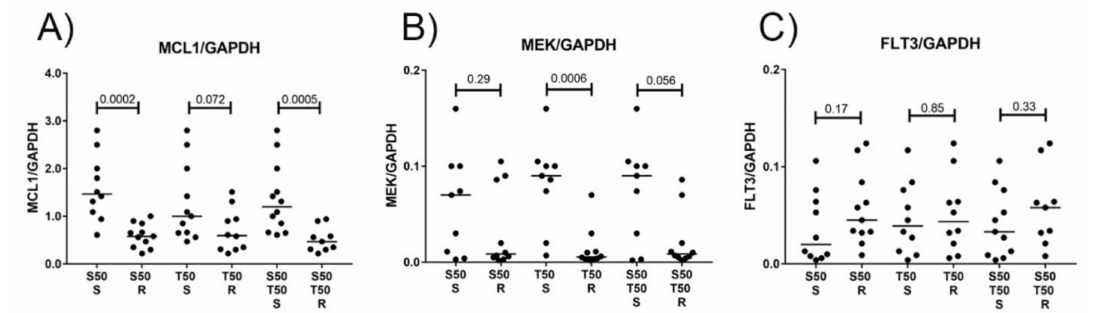
Figure 5. MCL1 and MEK1 protein levels are biomarkers for S63845 and trametinib treatment response in mononuclear cells isolated from patients with hematological malignancies. Relative protein levels of MCL1 / GAPDH( A ), MEK / GAPDH ( B ), and FLT3 / GAPDH ( C ) in mononuclear cells of 16 patients with hematological malignancies and 4 AML cell lines in correlation to susceptibility of hematological cells treated with 50nM S63845 (S50), 50nM trametinib (T50), or combination treatment (S50T50) for 20 h. Hematological cells with elevated MCL1 protein levels are susceptible to S63845, while hematological cells with elevated MEK protein levels are susceptible to trametinib. There is no correlation of FLT3 protein levels to susceptibility of hematological cells to S63845 or trametinib. The threshold of sensitivity was deliberately set at median levels of cell viability. Cells responsive at levels above / below the threshold were called susceptible (S) and resistant